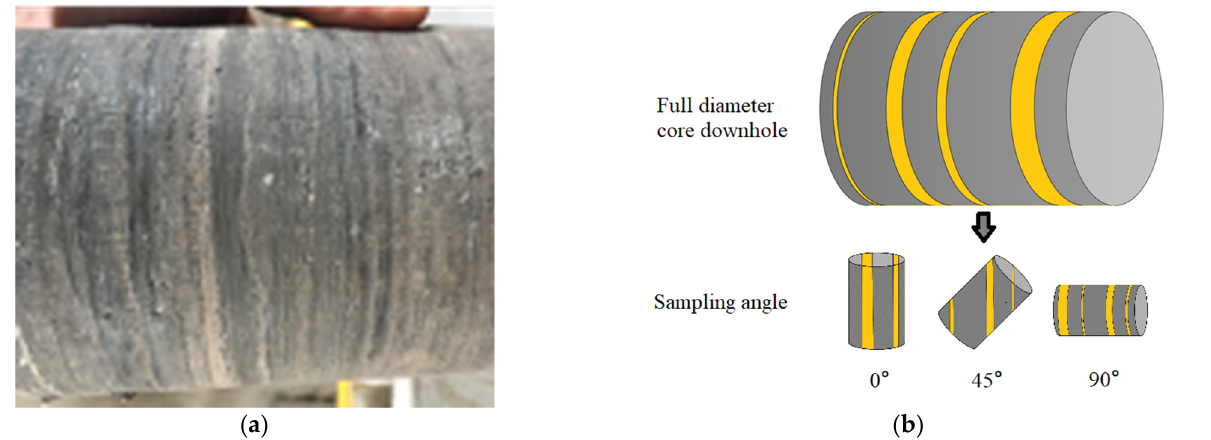
Figure 2. Full diameter core downhole and sample drilling processing method: ( a ) Full diameter core downhole; ( b ) sample drilling processing method.